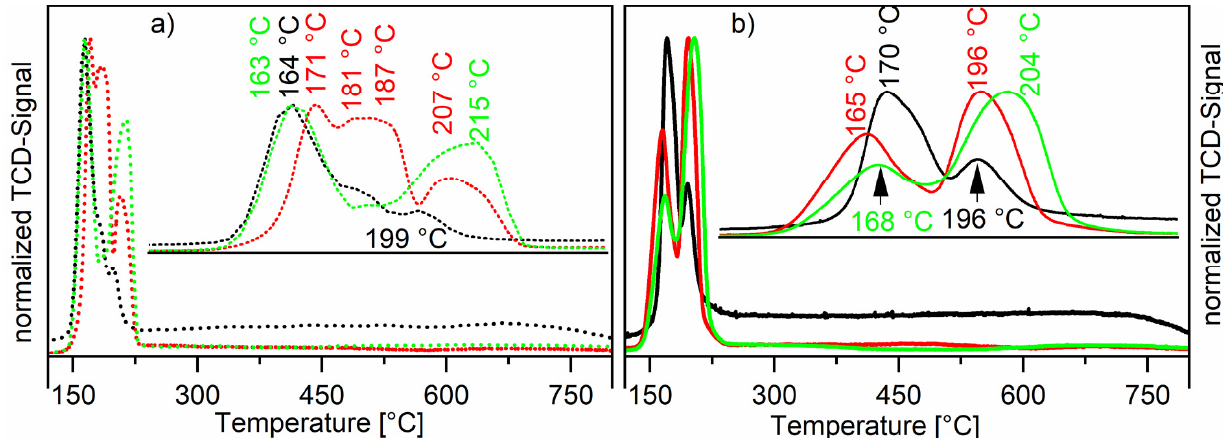
Figure 4. Normalised thermograms of the Ru-Cl-XX-ic. catalysts (Graph ( a ), dotted line) and Ru-NO-XX-ic. catalysts (Graph ( b ), compact line). The black line shows the thermograms of the Ru-XX-1-ic. catalysts, the red line shows the thermograms of the Ru-XX-3-ic. catalysts and the green line shows the thermograms of the Ru-XX-5-ic. catalysts.